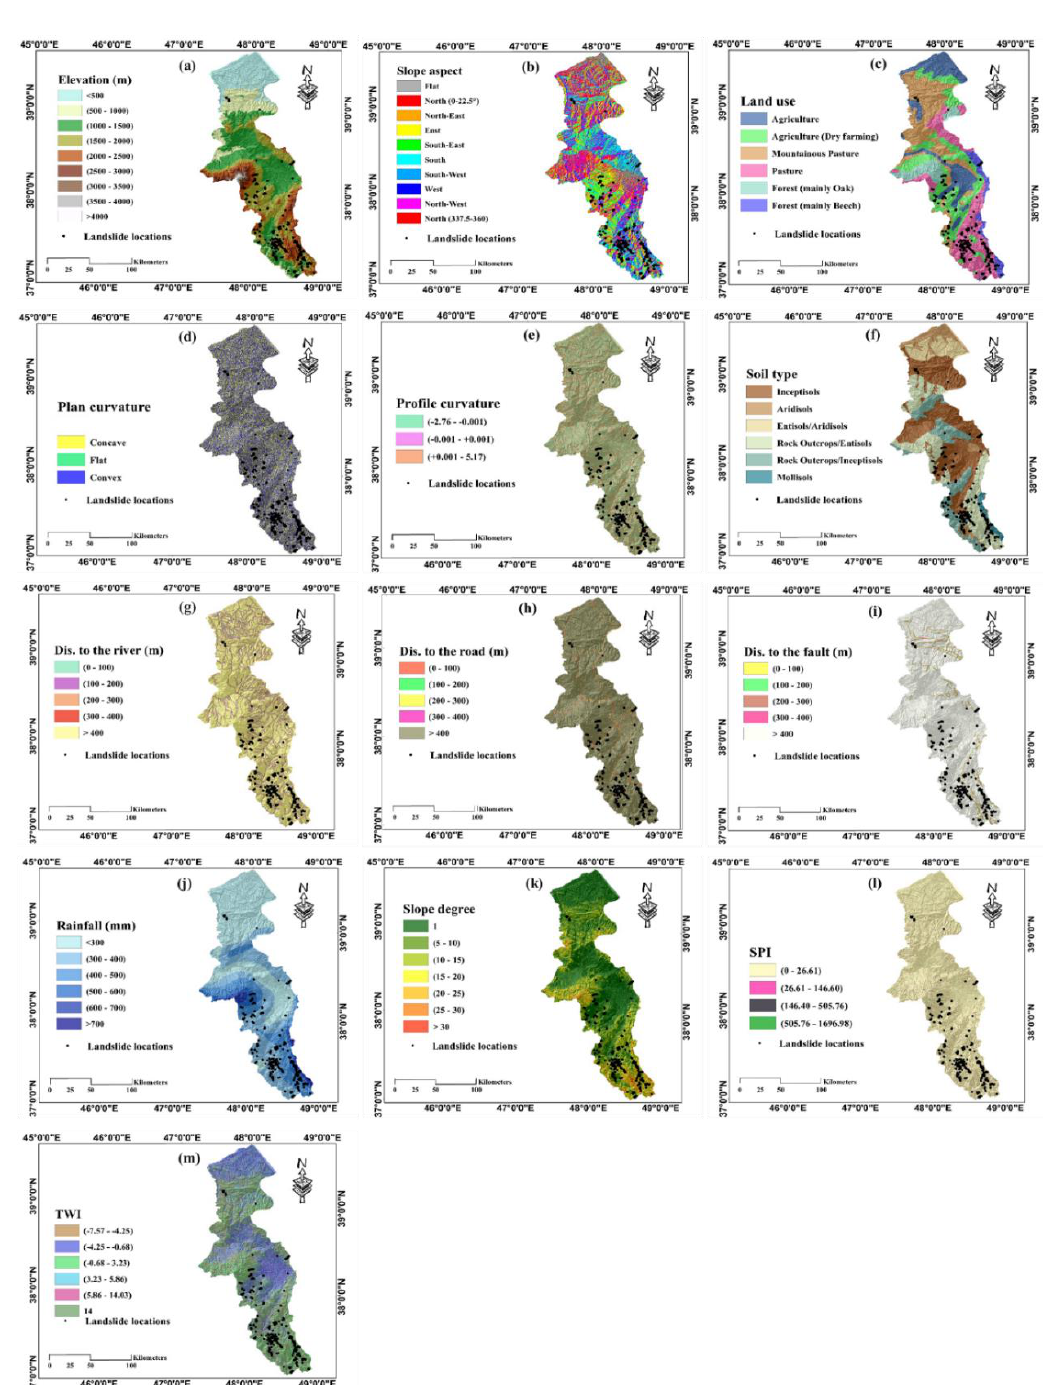
Figure 2. The map of: ( a ) elevation, ( b ) slope aspect, ( c ) land use, ( d ) plan curvature, ( e ) profile curvature, ( f ) soil type, ( g ) distance to river, ( h ) distance from road, ( i ) distance from fault, ( j ) rainfall, ( k ) slope degree, ( l ) stream power index (SPI) and ( m ), topographic wetness index (TWI) landslide conditioning